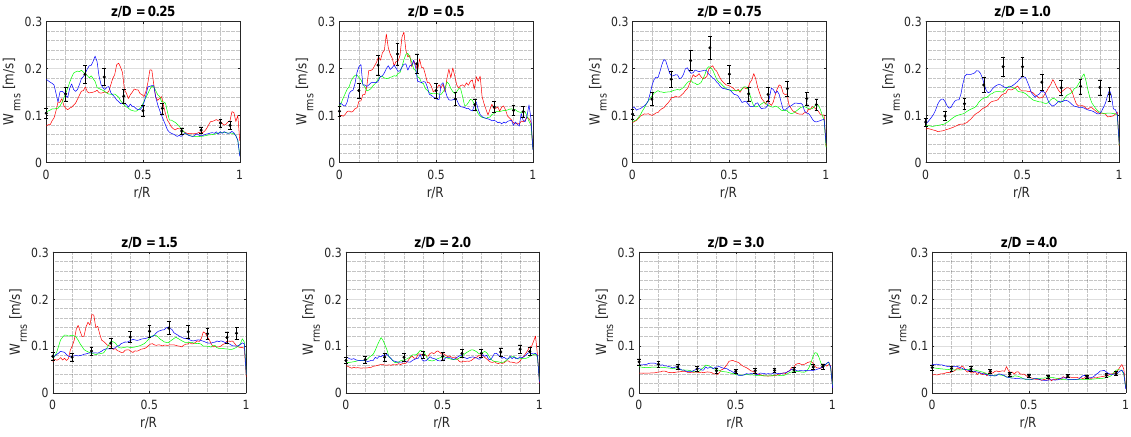
Figure 15: RMS of axial velocity at several cross sections for different mesh resolutions (red: Mesh 1, green: Mesh 2, blue: Mesh 3, dots: experiments)